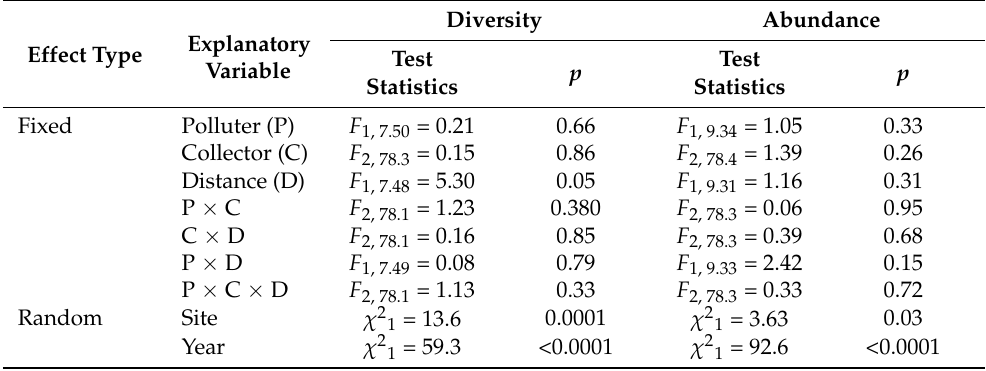
Figure 3. Abundance ( a ), diversity ( b ), and species richness ( c ) of moths and butterflies in relation to the distance from the Nikel copper – nickel smelter (black circles) and from the Zapolyarnyy ore- roasting plant (empty circles). Values are the means (± SE) ( a , b ) and the estimated means (± SE) from rarefaction analysis ( c ). Correlations refer to log 10 -transformed distance; the correlation with abundance is based on the square-root-transformed values. Table 3. Sources of variation in the abundance and diversity of Lepidoptera (SAS GLIMMIX proce- dure, type 3 tests).